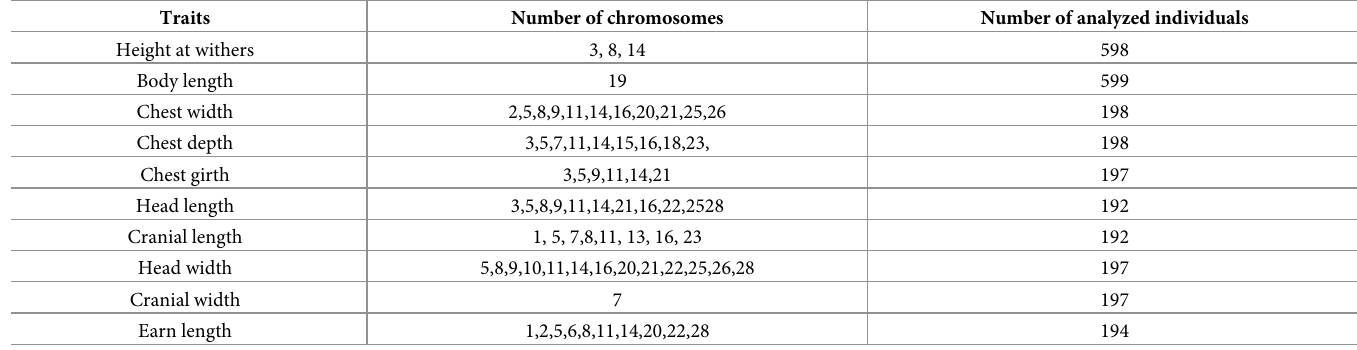
Table 5. Genome wide significant SNPs effects for quantitative